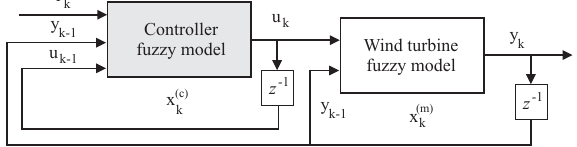
Figure 5. The fuzzy controller based on the inverse process model